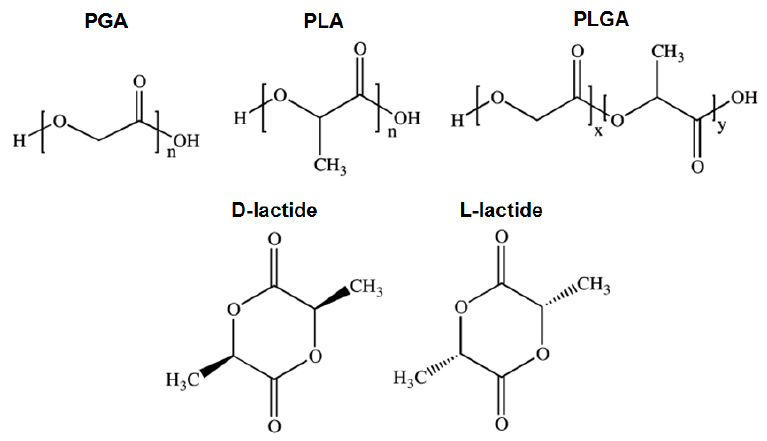
Figure 1. Chemical structure of PGA, PLA, PLGA and the enantiomers D- and L-lactide.